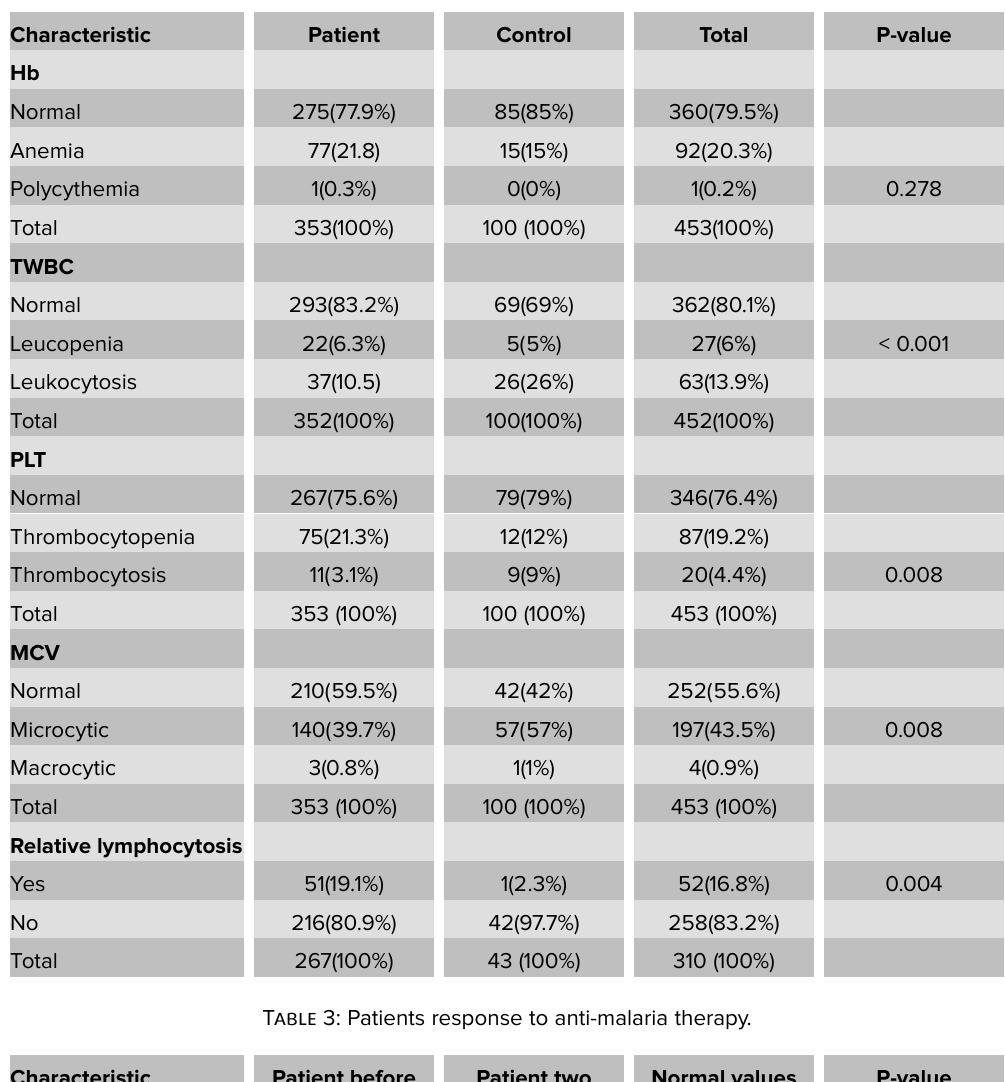
Table 2: Comparison of hematological parameters of the study groups.